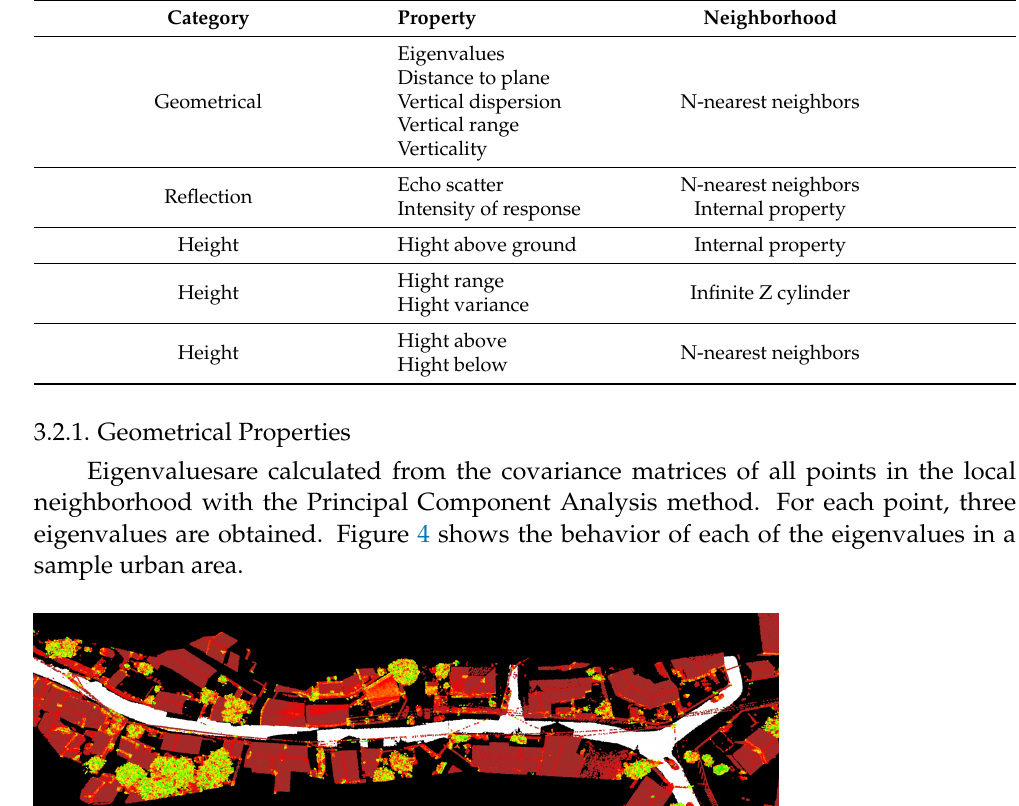
Table 2. Summary of training data and their properties.